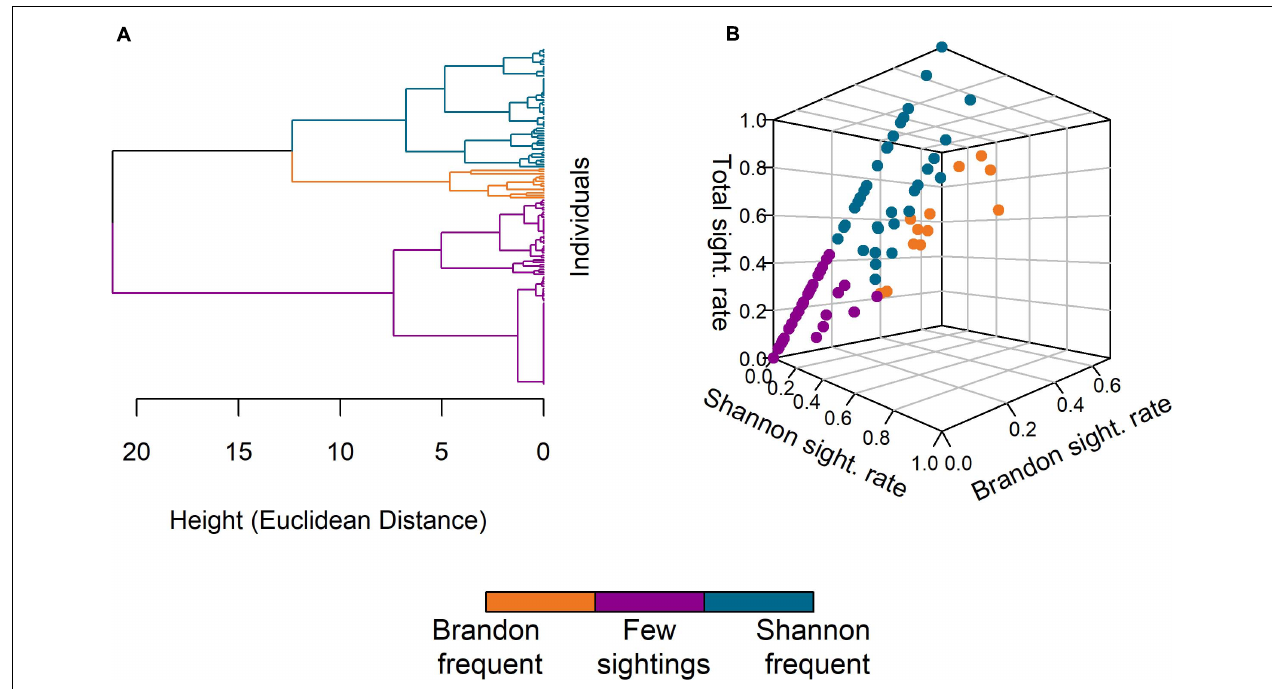
FIGURE 4 | Results of the agglomerative hierarchical cluster analysis. (A) The dendrogram of individual dolphins as obtained based on their sighting rates in Brandon/Tralee Bays, the Shannon Estuary and overall sightings. Euclidean distance was used as measure for the distance between individuals. (B) 3D-visualisation of the three clusters obtained after truncation of the dendrogram. The axes represent the three sighting rates (Shannon, Brandon, and Total). The groups identified are “Brandon frequent” (orange, n = 13), “Few sightings” (purple, n = 78), and “Shannon frequent” (blue, n = 50). TABLE 2 | Summary of the first three most parsimonious candidate models as obtained for each of the three modelling approaches, ranked by (Q)AICc. Model QAICc (cid:49) QAICc Akaike weight QDeviance ˆc No. of parameters